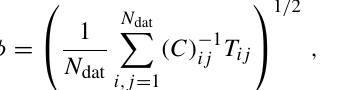
A PDF replica is then fitted to each pseudodata replica ( k ) D